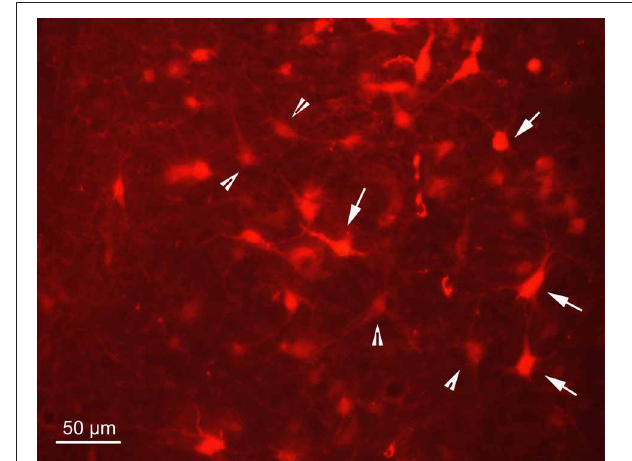
FIGURE 2 | Fluorescence photomicrograph demonstrating strongly labeled neurons (arrows) and less strongly labeled neurons (arrowheads) in the dorsal periaqueductal gray of rat SC2. The neurons were transsynaptically labeled after PrV Bartha injection into the m. rhomboideusafter a survival time of 100.5h. Scale bar represents 50 μ